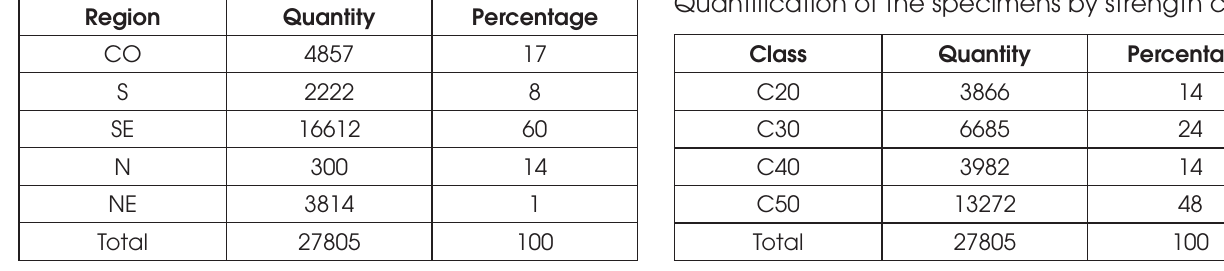
Quantification of the specimens by strength